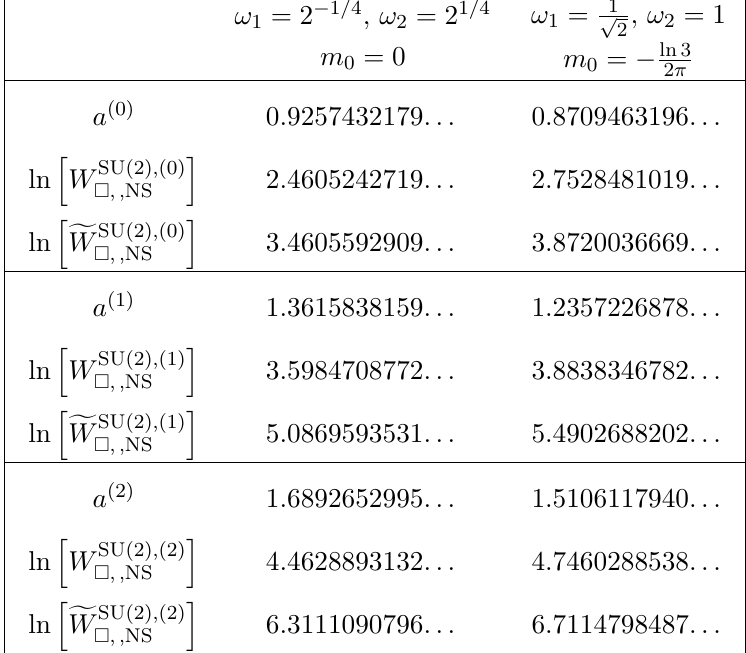
Table 5. Energies W SU(2) ; ( n )